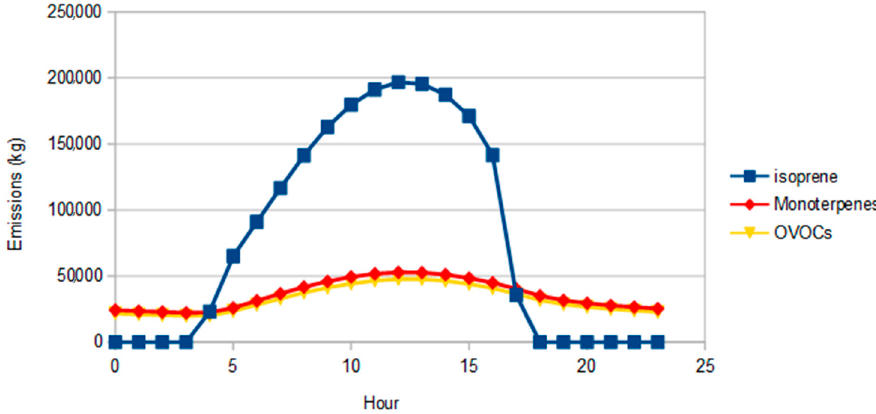
Figure 6. Diurnal variation of biogenic volatile organic compounds (BVOCs) emission rates above the entire modeling domain.